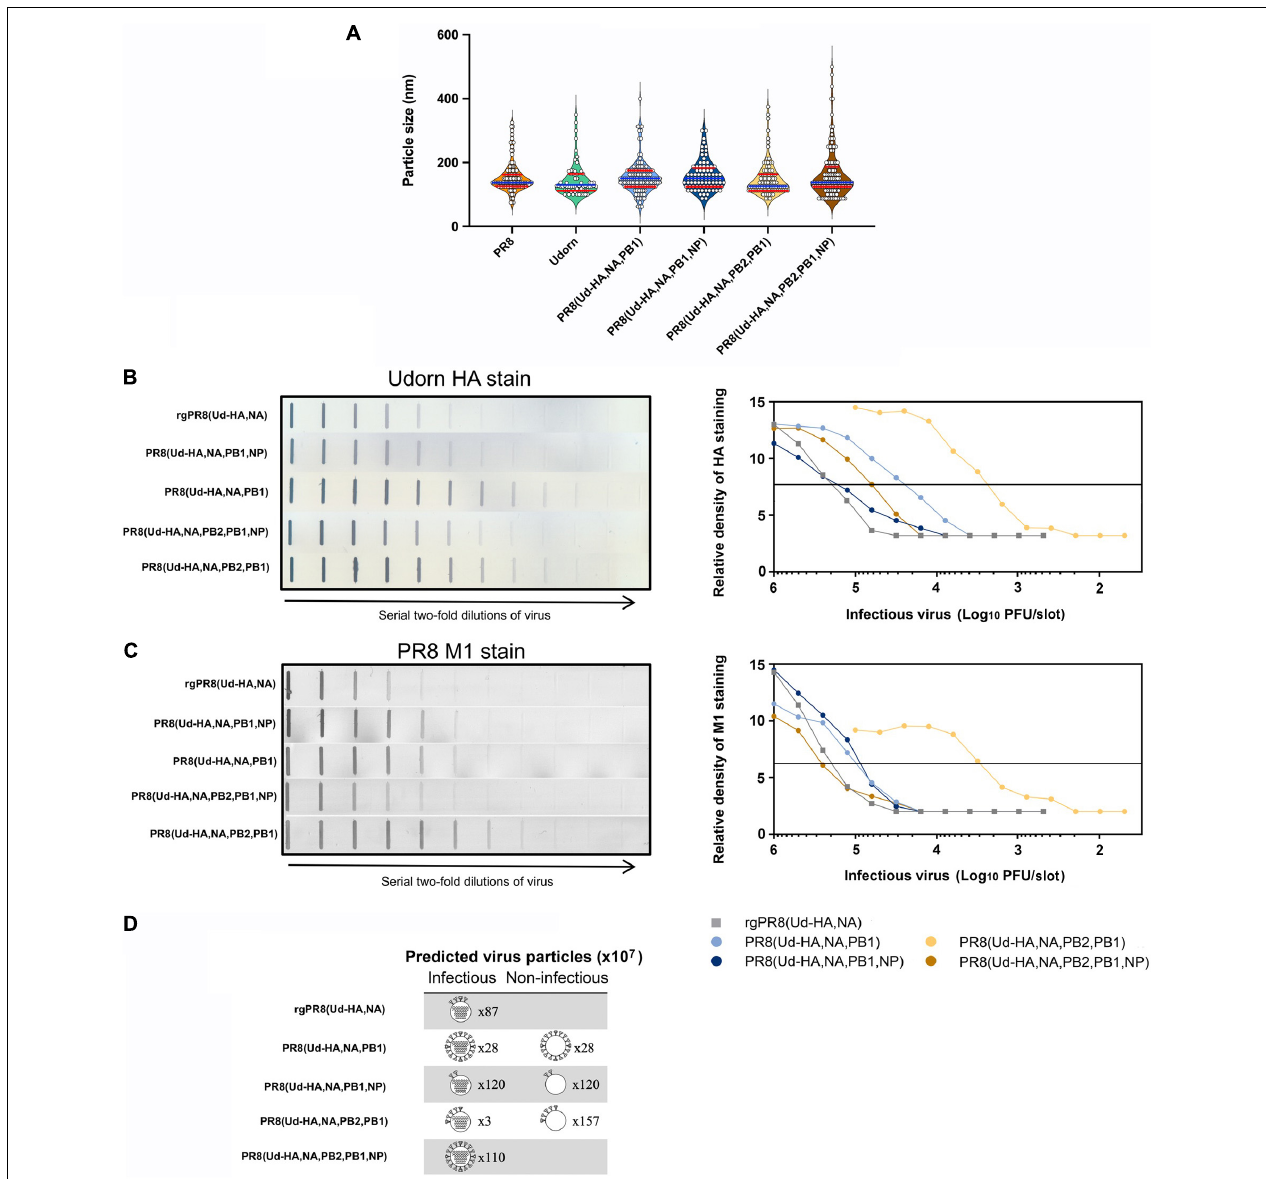
FIGURE 7 | The structure and HA protein content of reassortant viruses. (A) Violin plots of particle sizes visualised by transmission electron microscopy of infected allantoic fluid. White filled circles represent individual measurements along the longest axis of 60–130 distinctive viral particles from one to three printed images per virus preparation converted to nm. The median size is shown as a blue line with quartiles shown as red lines. Analysis by one-way ANOVA shows no difference in the mean particle size ( p = 0.27) (B,C) Allantoic fluid containing infectious virus was diluted to 10 7 PFU/ml, or 10 6 PFU/ml for PR8(Ud-HA,NA,PB2,PB1), and two-fold serial dilutions were performed. Each dilution (100 µ l) was transferred to a nitrocellulose membrane and the (B) Udorn HA protein or (C) PR8 M1 protein was detected with a mouse monoclonal antibody and visualised by secondary staining with rabbit anti-mouse HRP and the addition of substrate (left panels). Densitometry analysis was performed on the bands obtained in each of the strips and the peak heights were plotted against the amount of infectious virus in that sample (right panels). The horizontal line is used to determine the number of PFU required to provide an arbitrary amount of HA or M1 staining. The data is representative of two experiments. (D) Depiction of the relative amount of HA and its distribution between infectious and non-infectious virions. Infectious particles are depicted with gene segments; non-infectious particles are depicted without gene segments. The predicted number of particles ( × 10 7 ) is indicated beside each virion ( Table 2 ). For ease of representation one arbitrary unit of HA protein ( Table 1 ) is depicted as four HA spikes on the virion. The distribution of the HA protein was assumed to be equal between the infectious and non-infectious